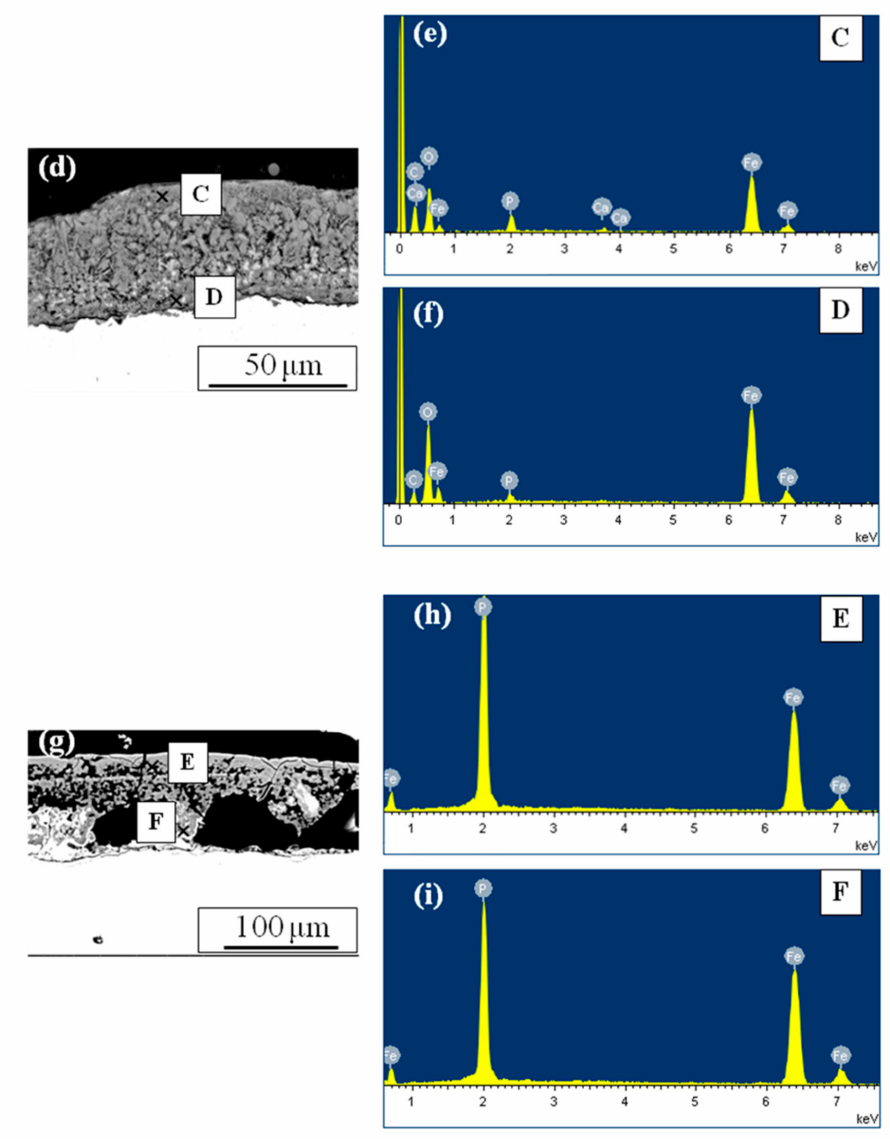
Figure 5. The cross-sectional morphology and EDX results of the rust treated by 5 g/L ( a – c ), 50 g/L ( d – f ), 200 g/L ( g – i ) phosphoric acid in conjunction with the tannic rust converter: the test points